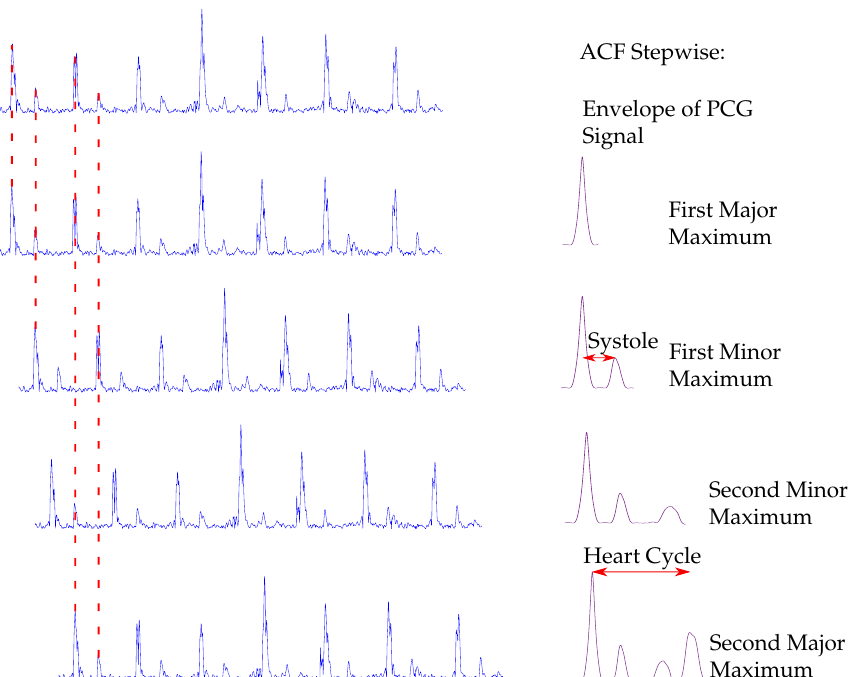
Figure 5. Procedure to determine the heart cycle and the systole length from the autocorrelation (ACF). On the left side the envelope of the PCG is shown. In the respective rows, it is shifted in time. For reasons of clarity and comprehensibility, dashed lines are not drawn for all heart sounds. On the right side, the corresponding ACF is